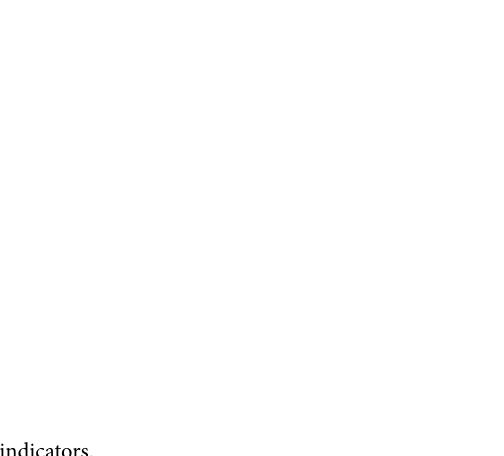
Figure 17. Comparison of the importance of geothermal high-value point indicators.